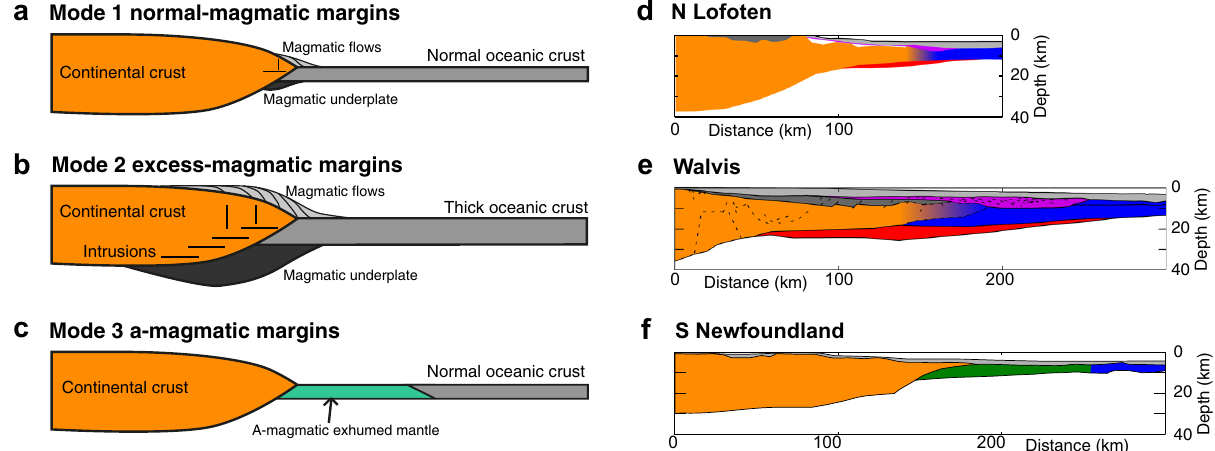
Fig. 1 Magmatic modes of rifted margins. Classi fi cation of rifted margins in terms of their magmatic modes: a normal-magmatic (Mode 1), b excess- magmatic (Mode 2) and c a-magmatic (Mode 3). Natural examples for the three magmatic modes: d N. Lofoten margin 47 , e Namibian Walvis margin 67 and f Newfoundland margin 56